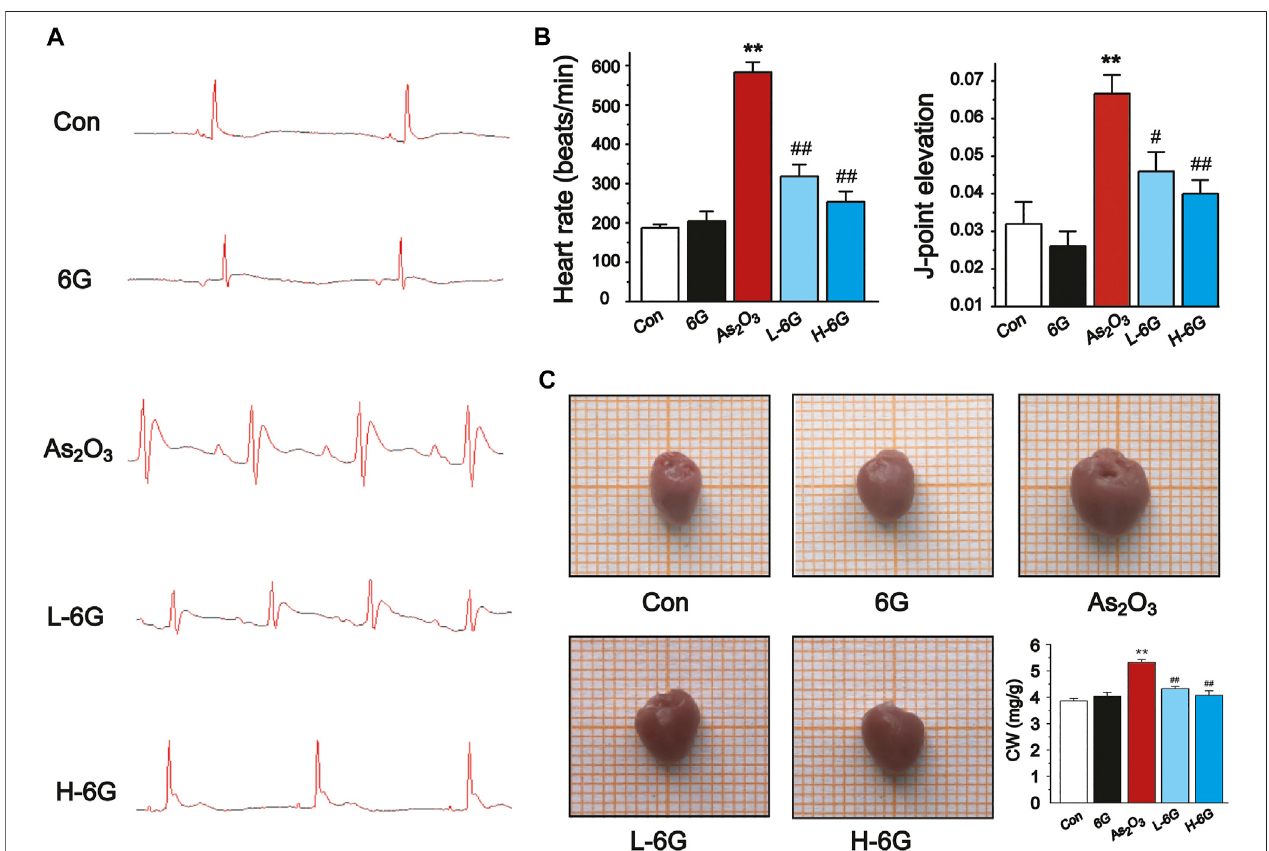
FIGURE 3 | Effect of 6G on ECG, heart rate, J-point elevation, and general appearance and coef fi cients. (A) Representative ECG waveforms were presented in each group. (B) 6G leads to a decrease in As 2 O 3 -induced heart rate acceleration and J-point elevation. (C) Representative pictures of the heart appearance and statistical analysis of CW were presented in each group. Data are represented as mean ± SEM, n = 4 – 6. ** p < 0.01 as in comparison to the Con group and # p < 0.05, ## p < 0.01 as in comparison to the As 2 O 3 group.